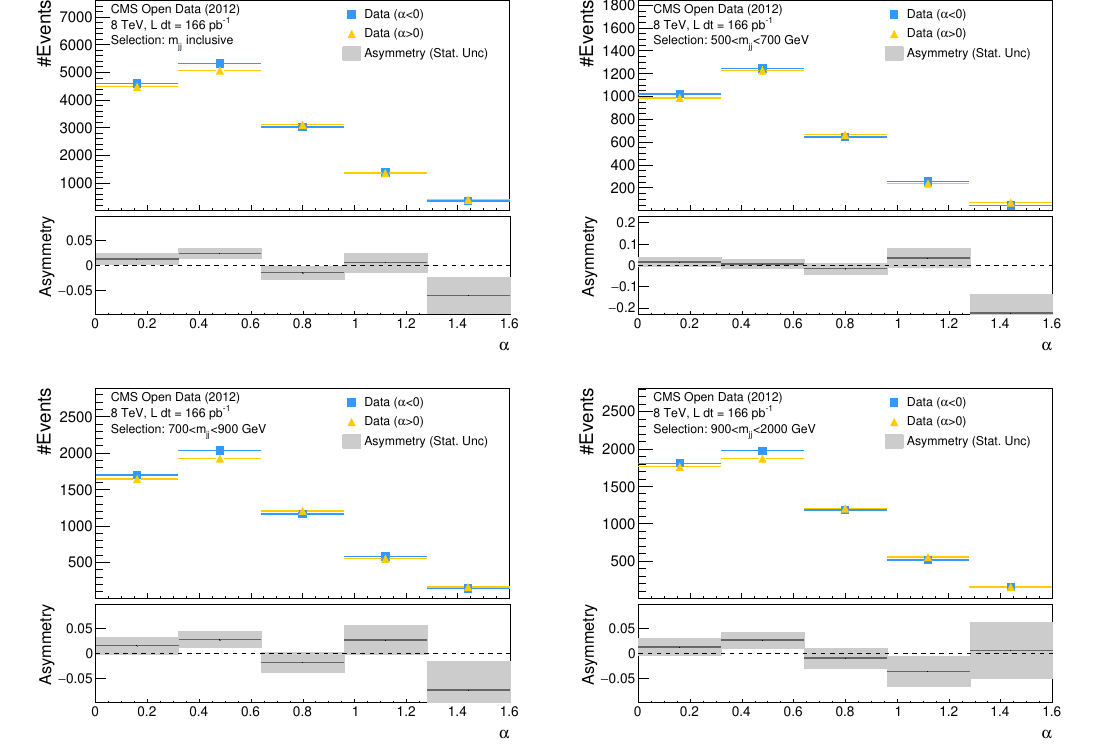
Figure 5 . Distribution of reconstructed events with (cid:11) < 0 and (cid:11) > 0 for all events (upper right), as well as three regions in the invariant mass m 12 ; upper right: 0 < m 12 < 700 GeV, lower left: 700 < m 12 < 900 GeV, lower right: 900 < m 12 < 2000 GeV. The ratio in each plots shows the asymmetry value including statistical